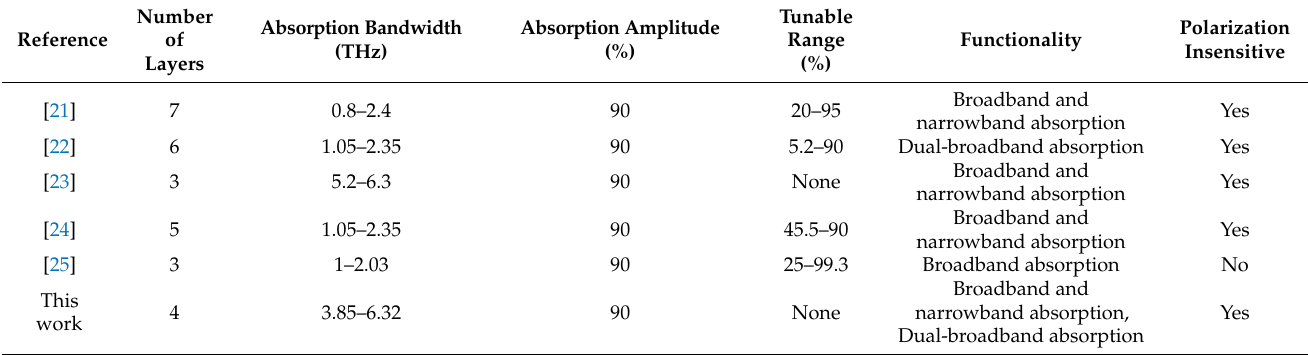
Table 2. Comparison of the broadband absorption performance between different absorbers.